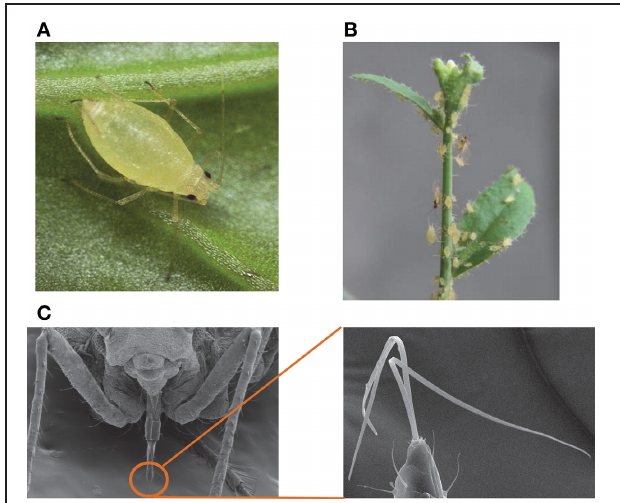
FIGURE 1 | Green peach aphid on Arabidopsis. (A) Green peach aphid on Chinese cabbage ( Brassica rapa var chinensis ). Images by Nick Sloff. (B) Green peach aphid on Arabidopsis thaliana . (C) Mouthparts of aphid. Left panel: SEM image of showing aphid mouthpart; Right panel: Aphid stylet. Images provided by John Diaz-Montano. The above images were adapted with permission from Louis et al. (2012c) Arabidopsis thaliana —Aphid Interaction. The Arabidopsis Book (First published on May 22, 2012:e0159. doi: 10.1199/tab.0159). Copyright American Society of Plant Biologists